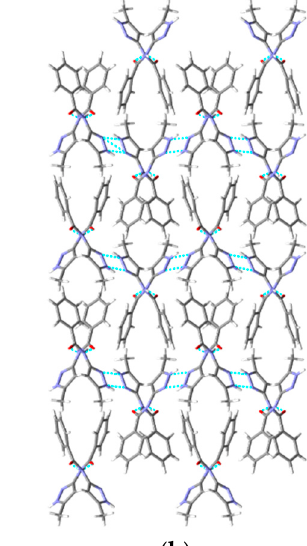
Figure 8. Hydrogen-bonding observed in the crystal structure of ( a ) P7 and ( b ) P8 along the crystallographic a -axis.